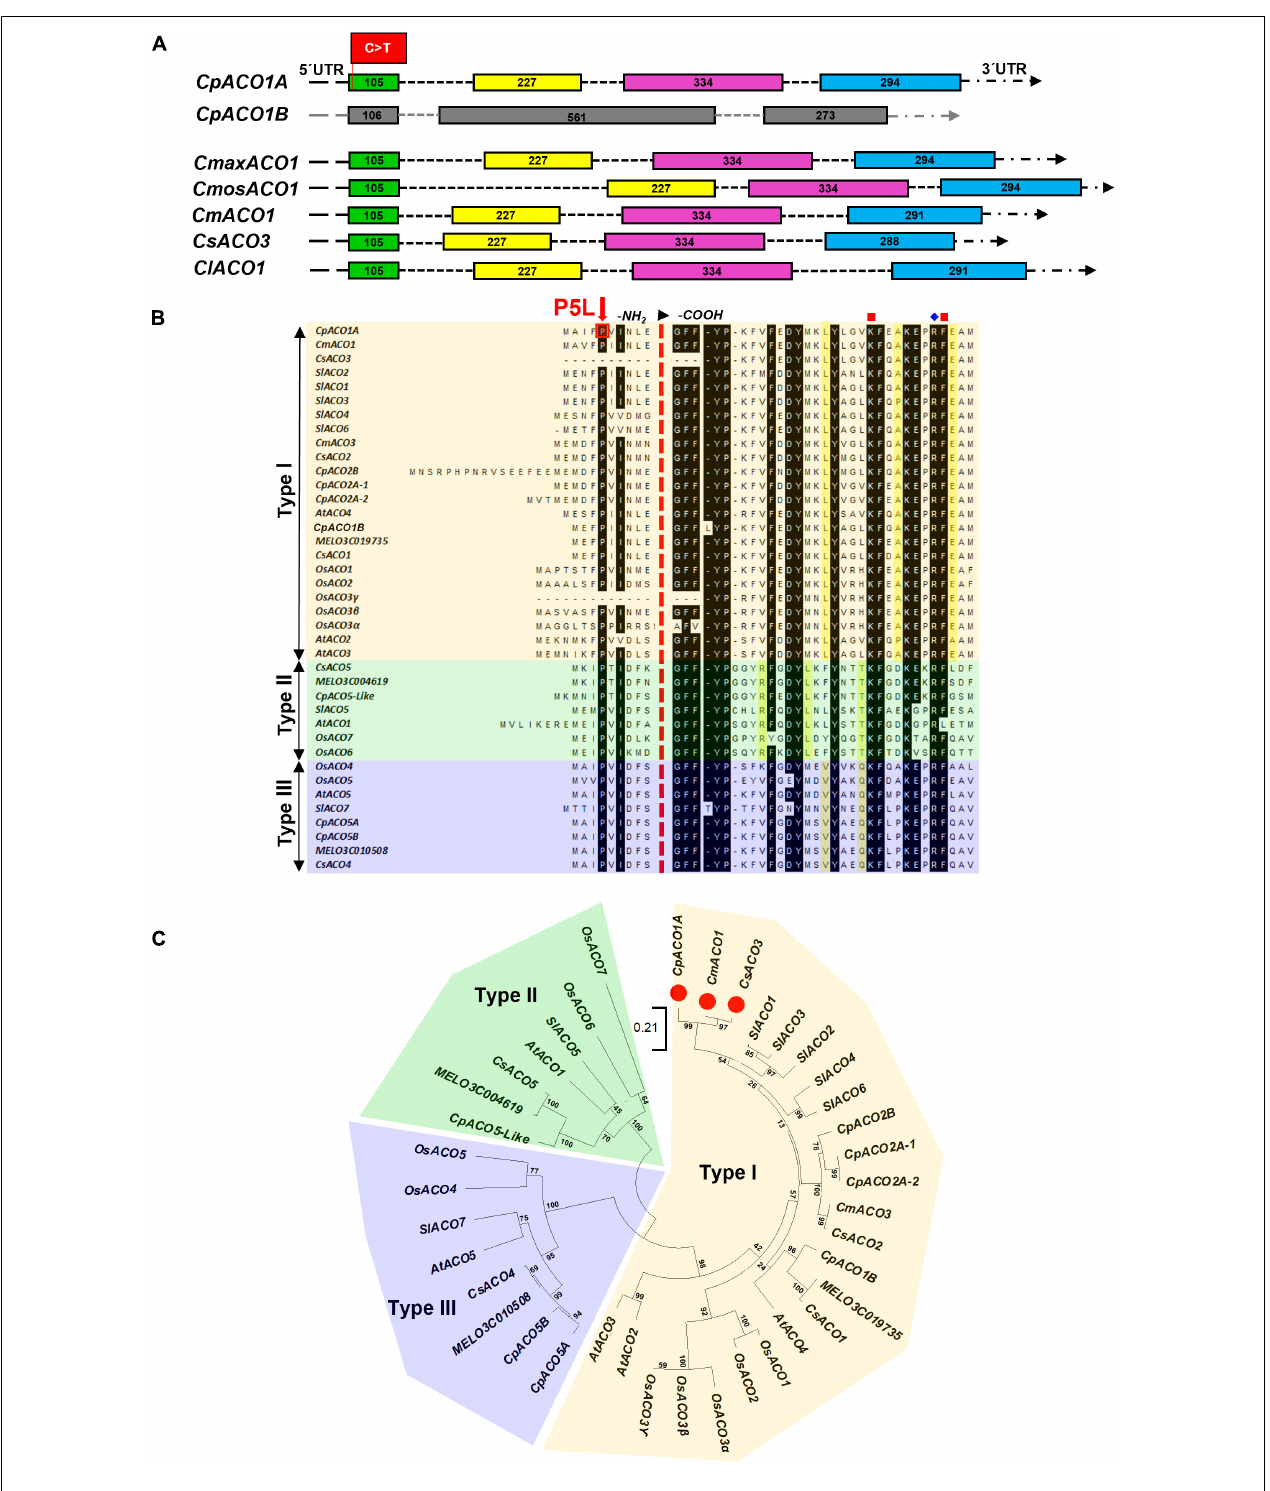
FIGURE 4 | Genetic relationships among ACO enzymes in different plant species. (A) Comparison of the gene structure of CpACO1A and CpACO1B of C. pepo with other homologs in cucurbit species: Cucurbita maxima ( CmaxACO1 ), Cucurbita moschata ( CmosACO1 ), Cucumis melo ( CmACO1 ), Cucumis sativus ( CsACO3 ), and Citrullus lanatus ( ClACO1 ). (B) Consensus proline residue in position 5 and ACO classification according to conserved residues in a specific position toward the -COOH end of the proteins. (C) Phylogenetic ACO tree from different cucurbit species: C. melo , C. sativus , and C. pepo together with those of the most studied model species, Arabidopsis thaliana , Solanum lycopersicum , and Oryza sativa . Bootstrap values for the main branches are depicted on the tree.